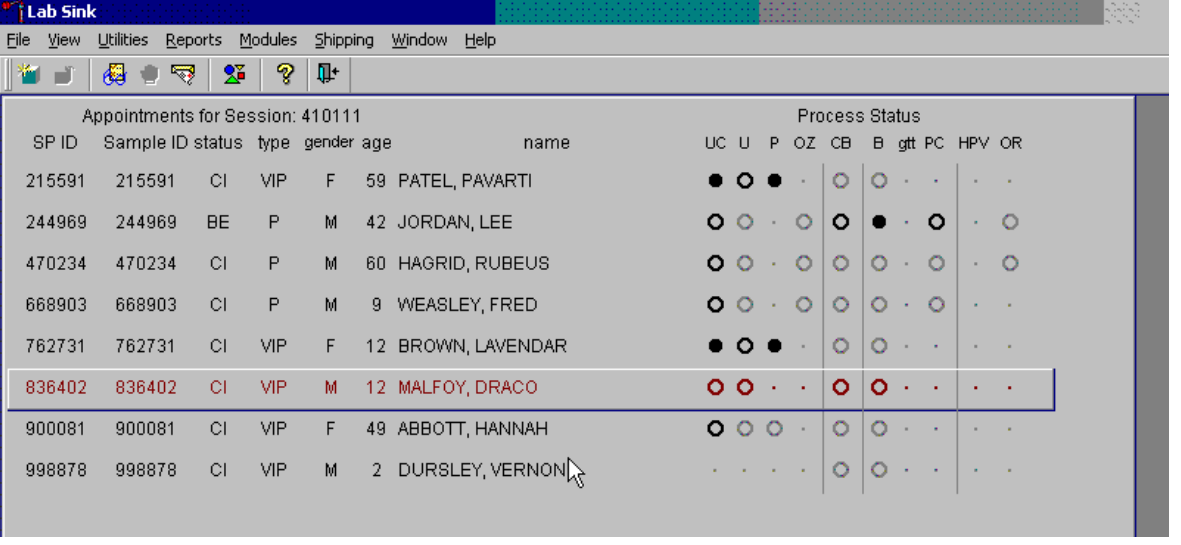
Do not process the SP’s specimens if the line on the heads-up display is